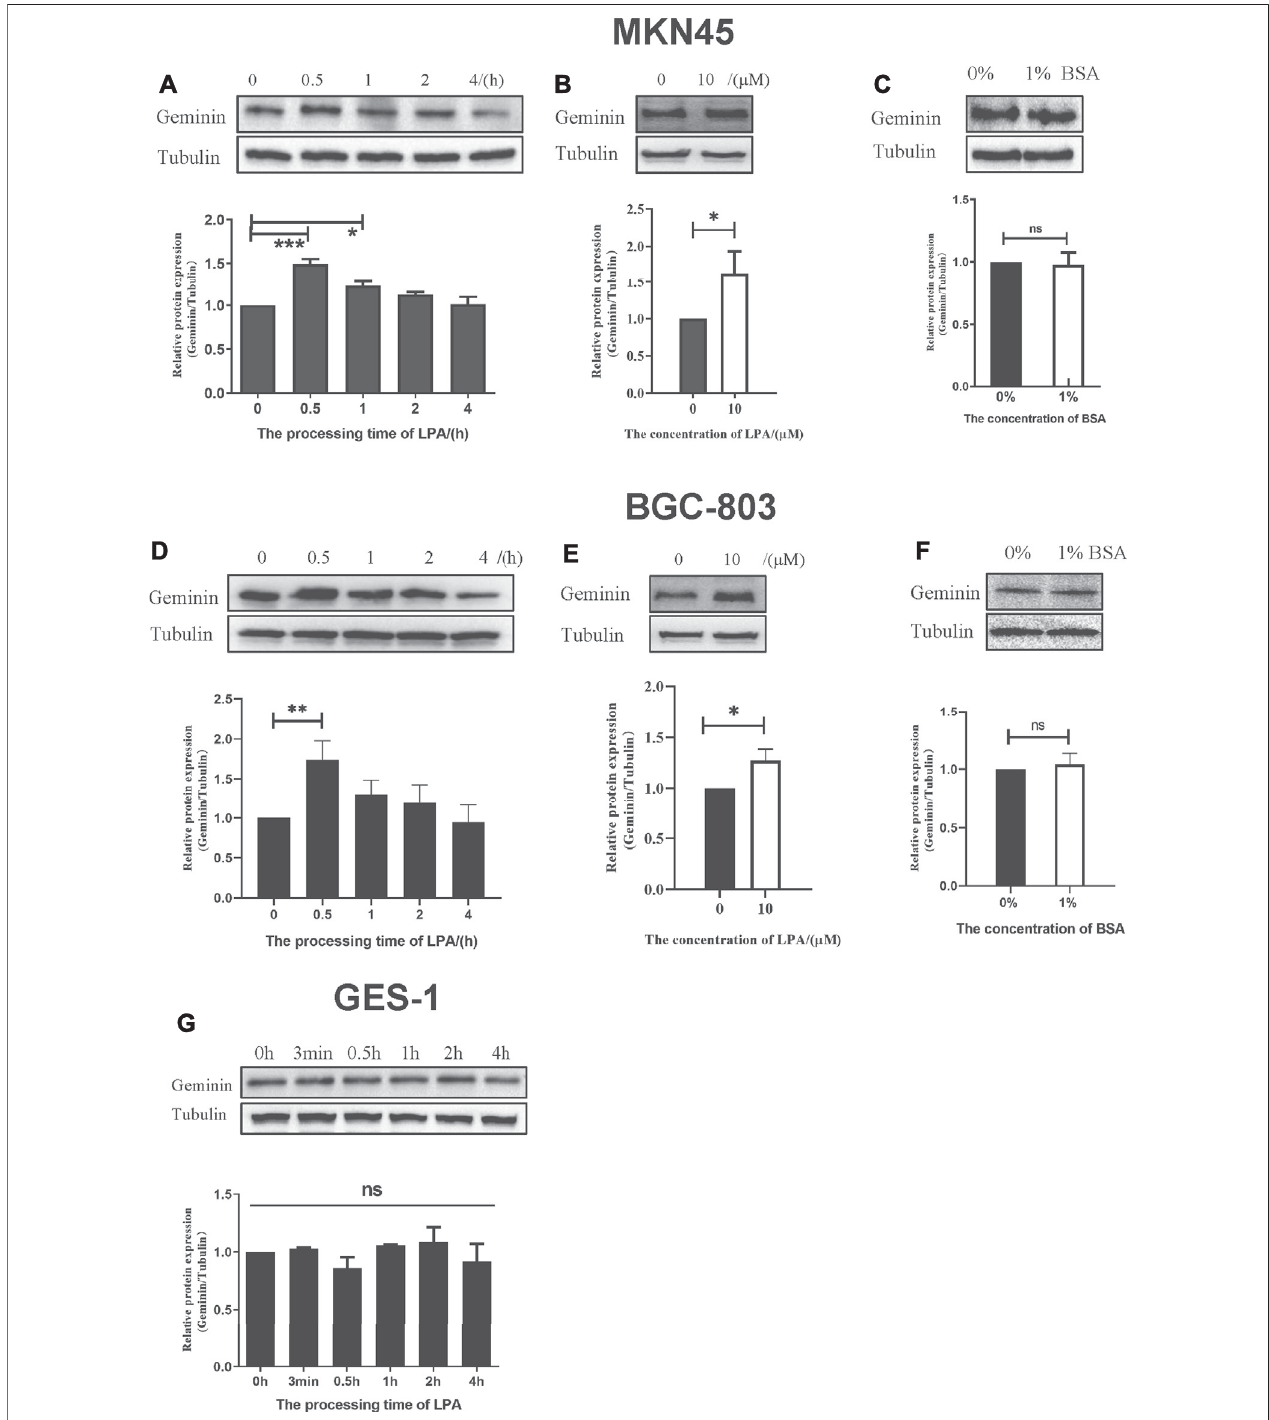
FIGURE 3 | LPA selectively triggers the upregulation of geminin in gastric cancer cells. (A, D, G) G1/S – arrested cells were treated with LPA time gradient. (B, E) Protein level of geminin with or without 10 µM LPA treatment. (C, F) G1/S – arrested cells were under the treatment with or without 1% BSA. Densitometry of three independentexperimentswasperformed,normalizedtotubulinandexpressedasaratioof0 hor0 µM,respectively.Mean ± SD,* p < 0.05,** p < 0.01(ANOVAtestand Dunnett ’ s multiple comparisons test )